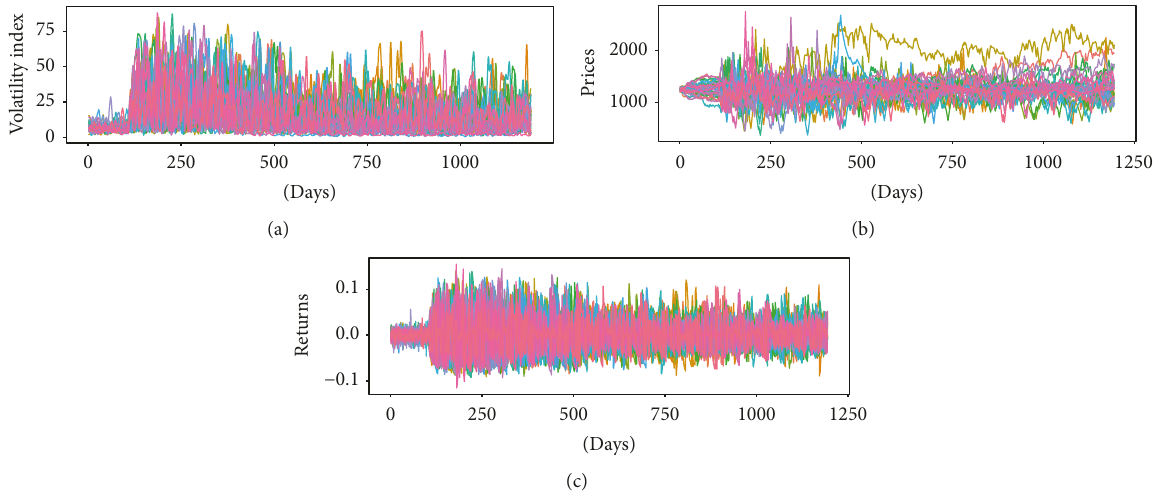
Figure 11: Time series of volatility index (a), prices (b), and returns (c), when 𝑔 = 1 = 𝑔 = 2 = 𝑔 = 3 = 1